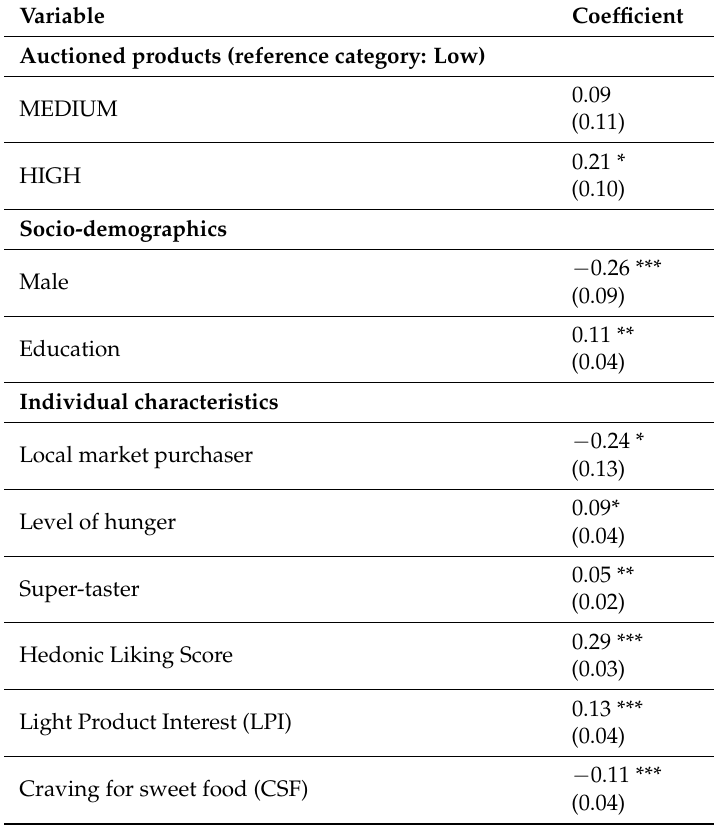
Table 4. Selected parameter’s estimates of the Tobit model for WTP collected during the blind round (Round 1).